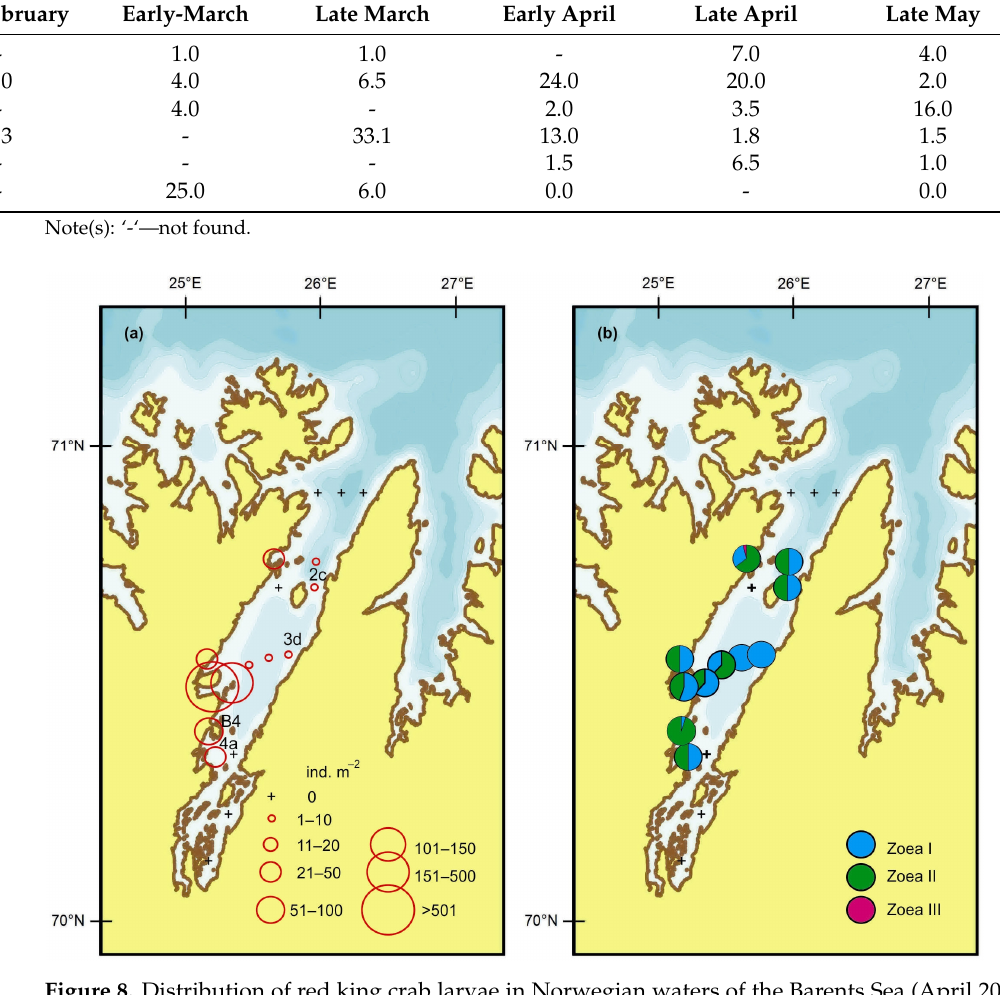
Figure 8. Distribution of red king crab larvae in Norwegian waters of the Barents Sea (April 2013, Porsangerfjord) (modified from [87]): ( a ) abundance (individuals m –2 ), ( b ) stage structure. 2c, 3d, B4, and 4a represent codes for sampling stations.